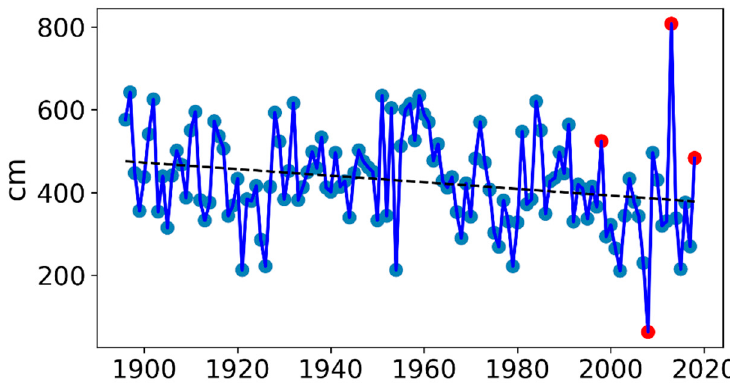
Figure 2. The Amur River annual maximum water levels near Khabarovsk for the period 1896–2018. Red points are dates with significant recorded events (Table 1).